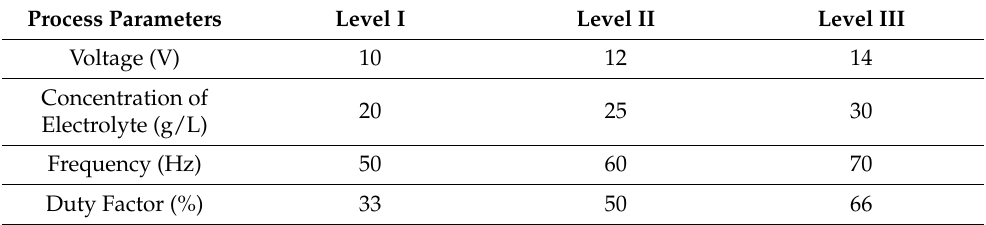
Table 1. Selection of process